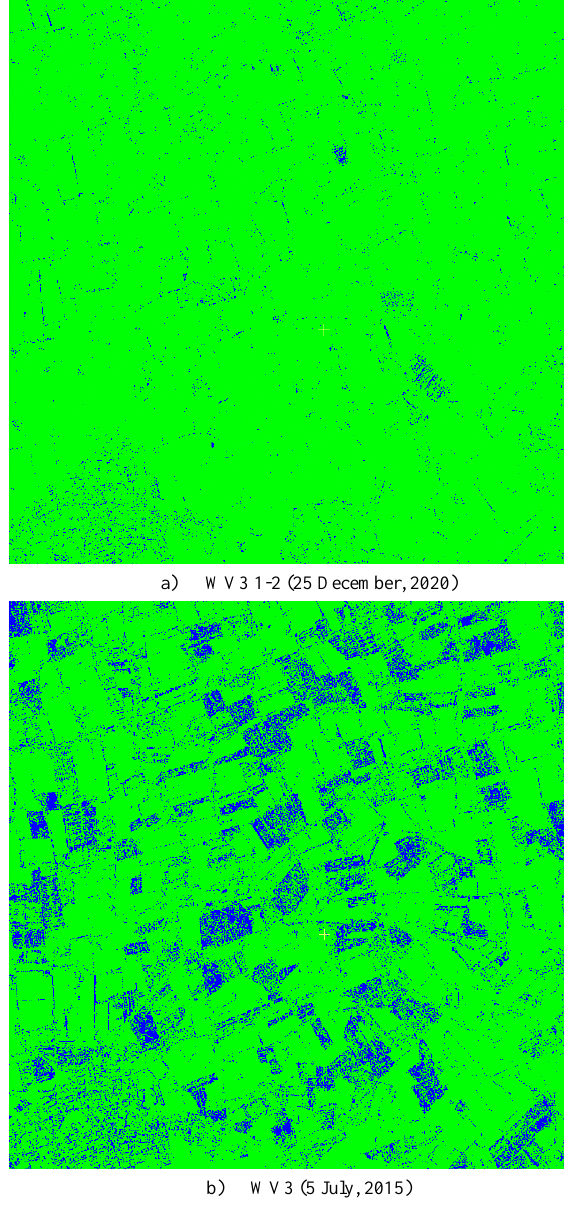
Figure 8. Score channel corresponding to DSM from WV3 stereo pairs over a square area of 2,500 m x 2,500 m: a) WV3 stereo pair 1-2 taken on 25 December, 2020; b) WV3 stereo pair taken on 5 July, 2015 and used by Aguilar et al.